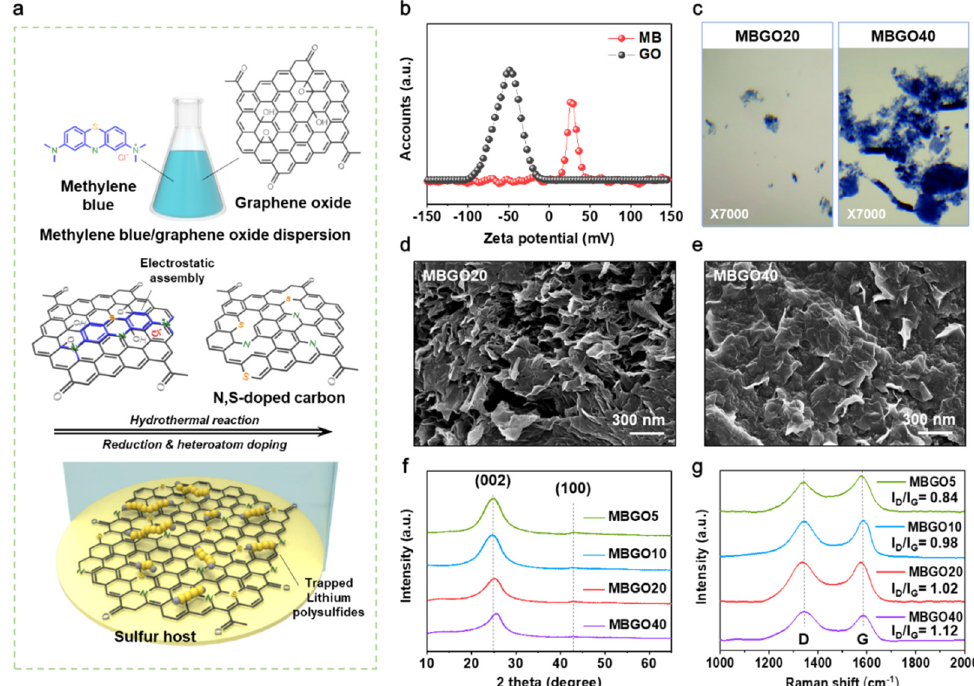
Figure 1. ( a ) Schematic of the preparation process of N, S–doped carbon as a sulfur host. ( b ) Zeta potential of graphene oxide and methylene blue. ( c ) Optical microscopy observations of the bottom of vial for MBGO20 and MBGO40 solutions. SEM image of ( d ) MBGO20 and ( e ) MBGO40. ( f ) XRD patterns and ( g ) Raman spectra of MBGOs with different MB con-tents.